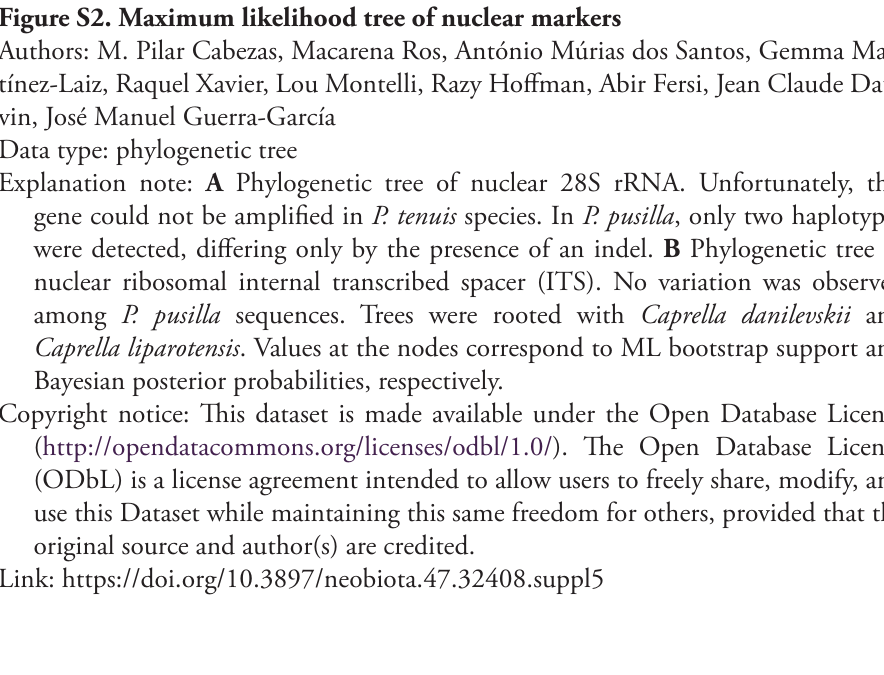
Figure S2. Maximum likelihood tree of nuclear